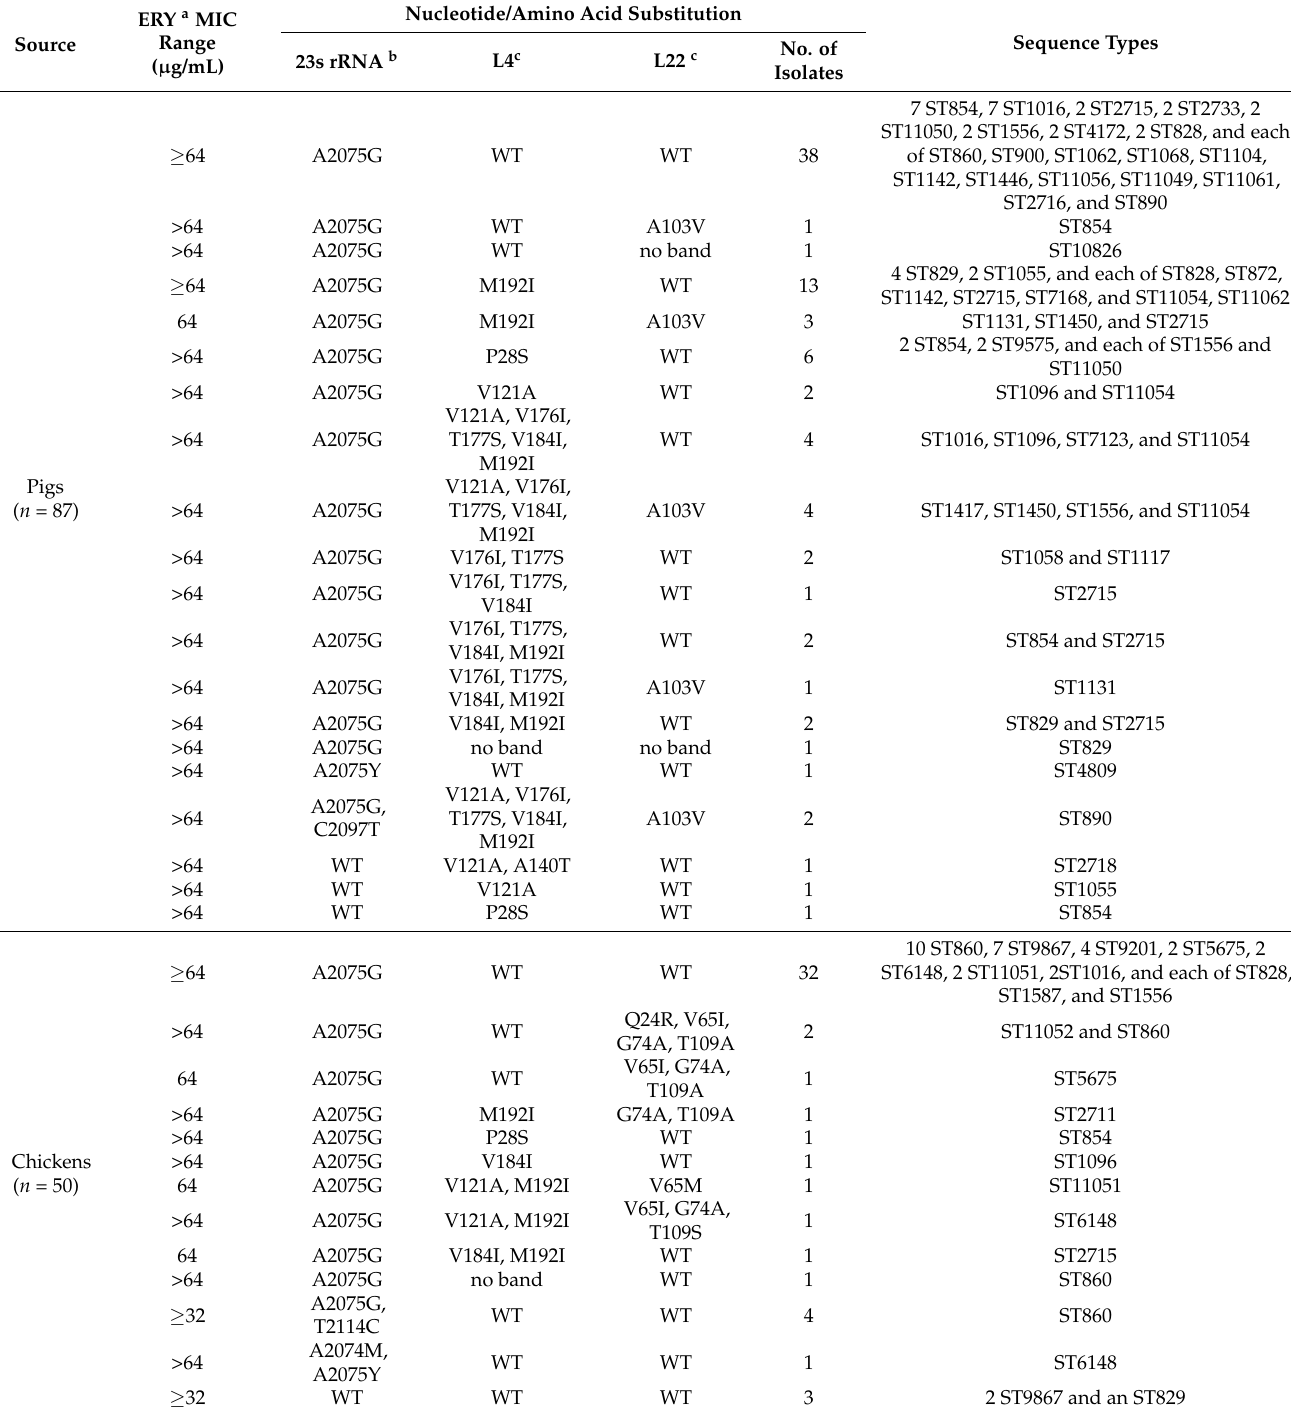
Table 3. Mutations in erythromycin-resistant C. coli isolated from pigs and chickens from 2010 to 2018 in